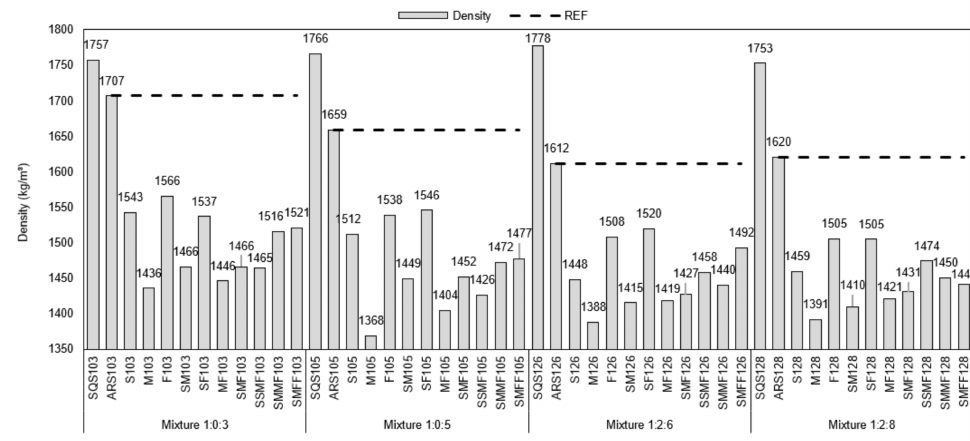
Figure A2. Bulk density in the fresh state.